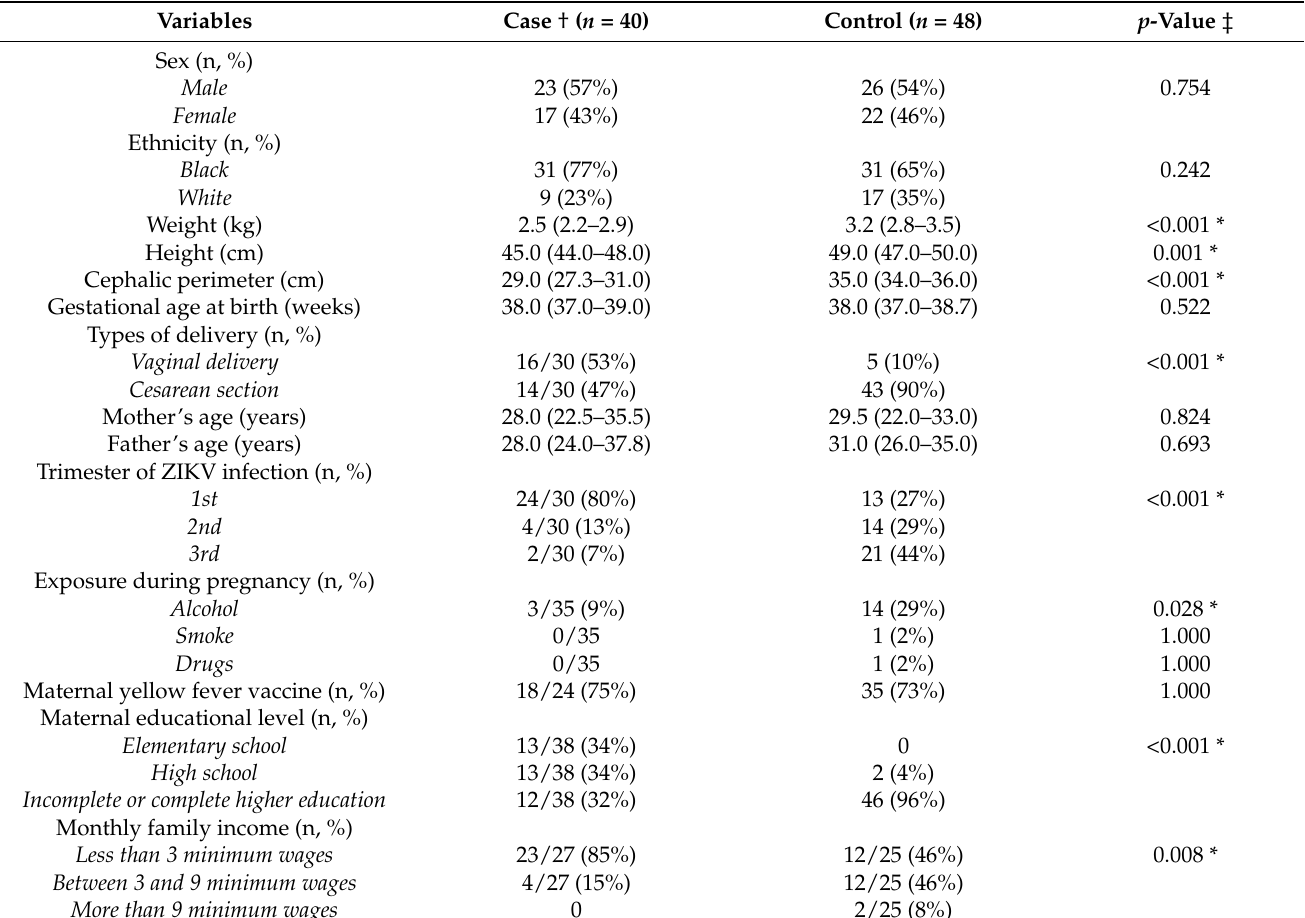
Table 1. Evaluation of Clinical, Gestational, and Sociodemographic Characteristics in the Case and Control Groups.